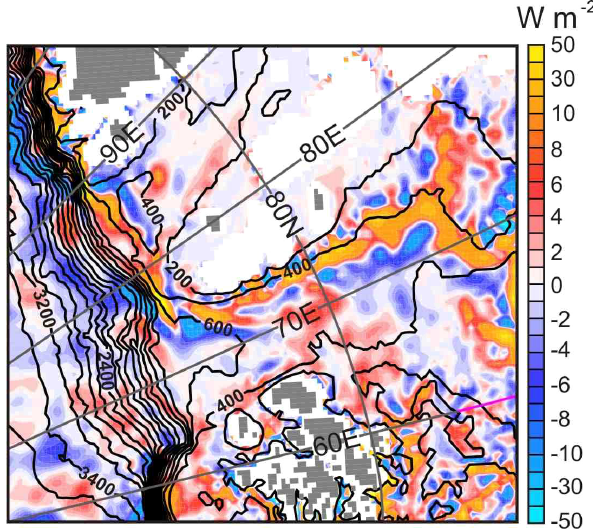
Figure 9. The 7-year mean (2003–2010) simulated vertical heat fluxes (Wm − 2 ) across the upper SFSBW interface at 75m show- ing enhanced heat loss over the ST eastern flank as well as over the Nansen Basin continental margin. Positive numbers indicate up- ward heat flux. The bathymetry is in meters. Yellow dashed rectan- gular depicts the area over the ST eastern flank where the simulated heat flux is averaged for compiling the time series shown in Fig. 10.